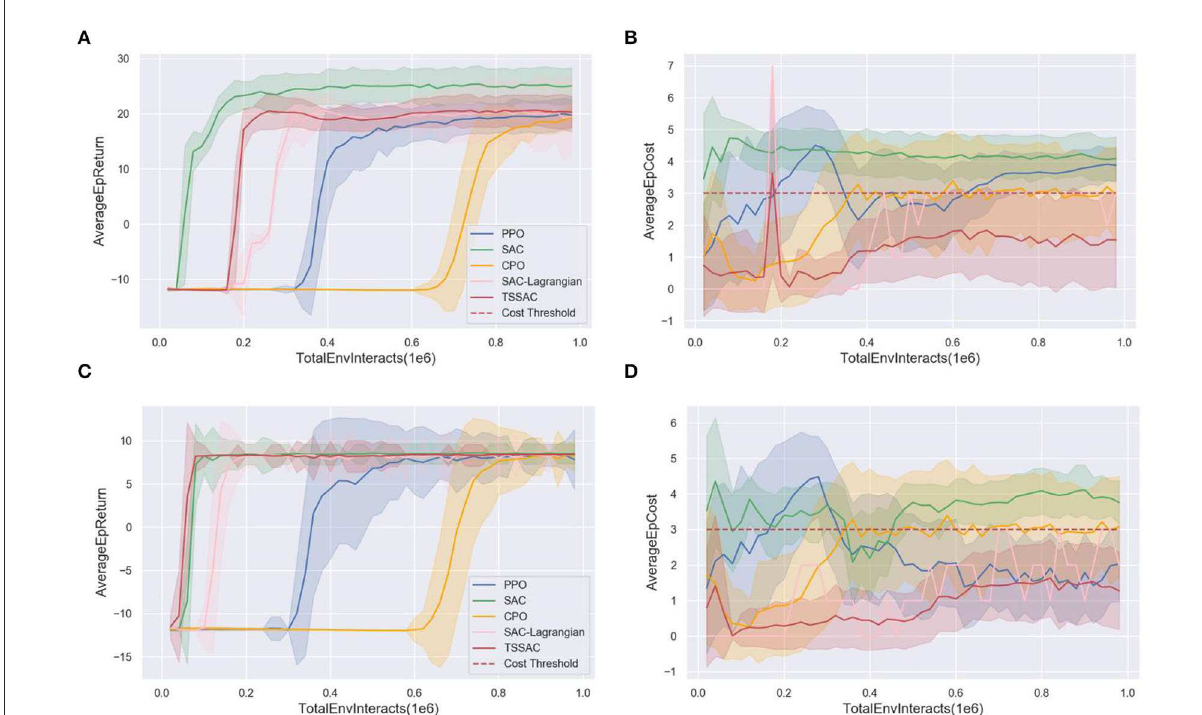
FIGURE7 Comparison of the five algorithms during training. (A) The task performance curve of the detect UAV. (B) The safety curve of the detect UAV. (C) The task performance curve of the strike UAV. (D) The safety curve of the strike UAV.